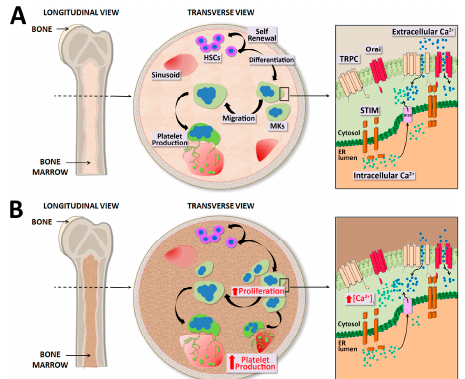
Figure 1. Store-Operated Ca 2+ Entry (SOCE) in physiological and pathological thrombopoiesis. ( A ) Bone marrow, contained in spongy bones, is a tridimensional network of branching sinusoids